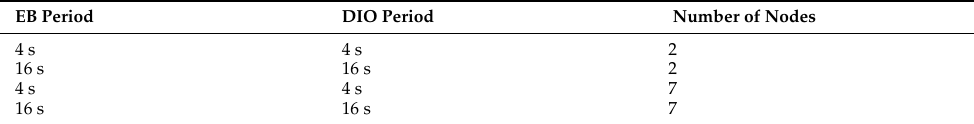
Table 6. Real testbed configuration parameters.